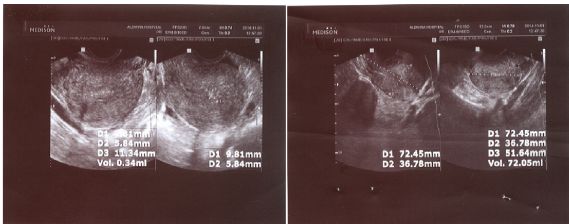
Figure 1: Abdominal ultrasonography view of patient before any treatment protocol.